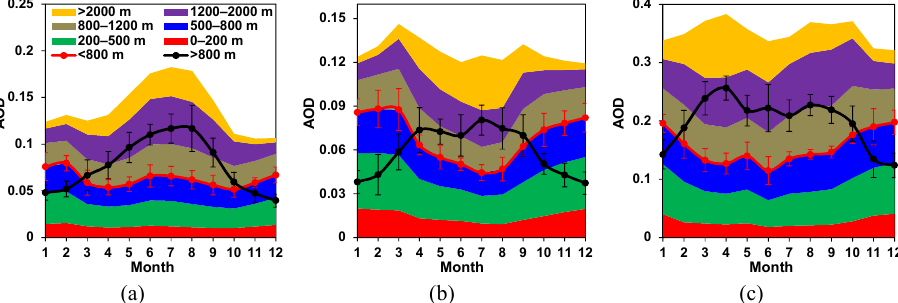
Figure 4. Monthly mean AOD as a function of height above ground level observed by CALIPSO during 2007–2016 in (a) EUS, (b) WEU, and (c) ECC. Only clear-sky daytime profiles are averaged in order to be consistent with the products of MISR and MODIS. The range of AOD within a particular height range is depicted by the colored stacks. The integrated AODs for heights below and above 800m are shown as solid lines, for which the error bars are defined in the same way as in Fig. 2. Note the different scales on the y axes of the plots.